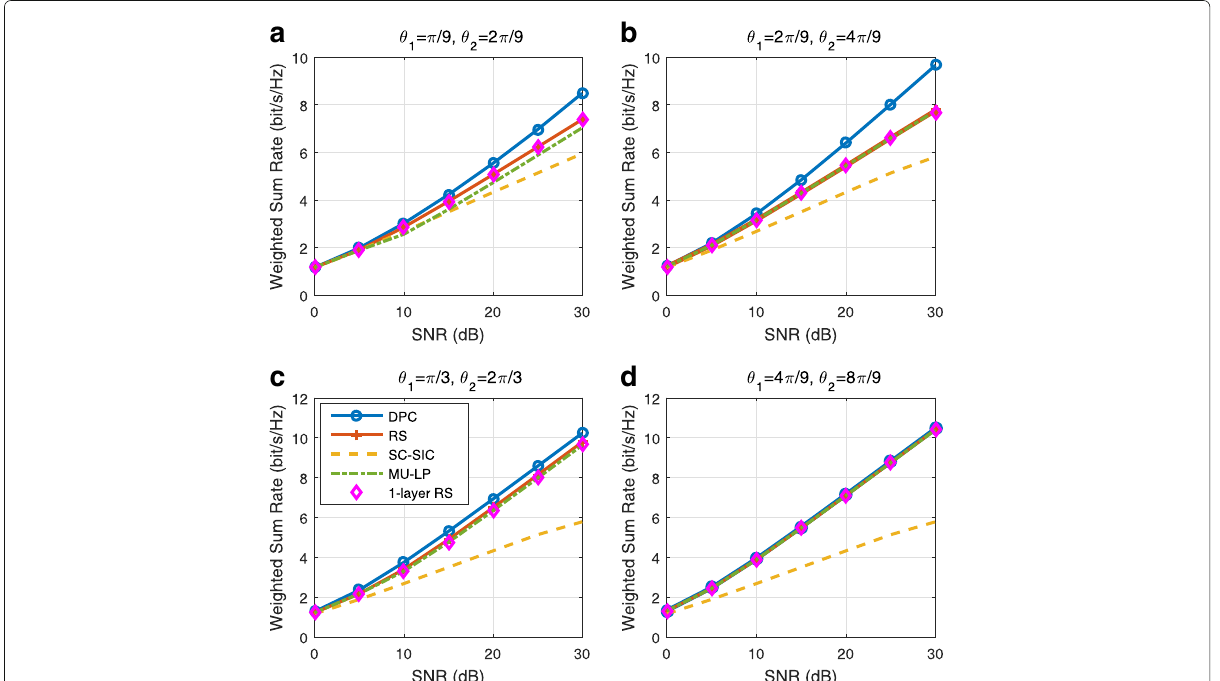
Fig. 32 Weighted sum rate versus SNR comparison of different strategies for underloaded three-user deployment with perfect CSIT, γ 1 = γ 2 = 1,